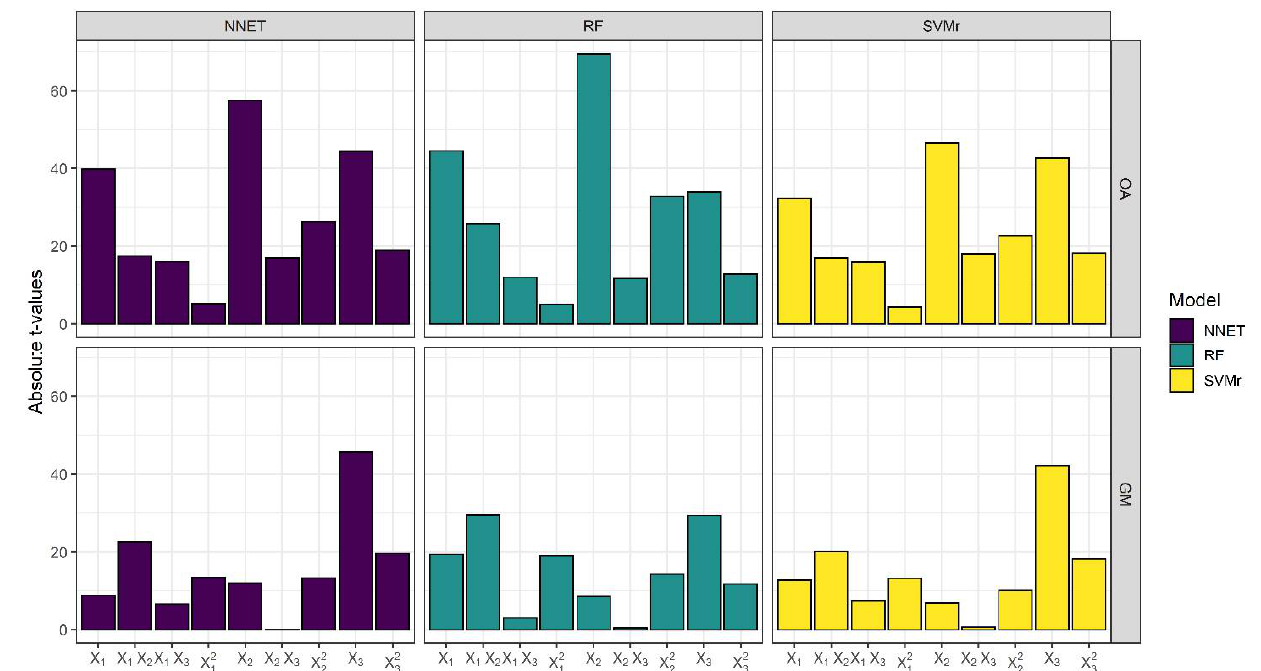
Figure 6. Absolute t-value of each regression coefficient retrieved by RSM models. Table 5. Best fit of the quadratic equation for each classifier and each response variable. The inde- pendent variables X 1 , X 2 , and X 3 are the coded values for the number of tomato training sites, the number of ‘other crops’ training sites, and lead time.